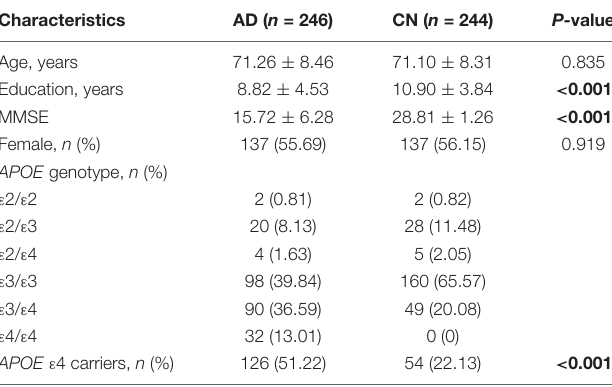
TABLE 1 | Demographic and clinical characteristics of subjects included in the